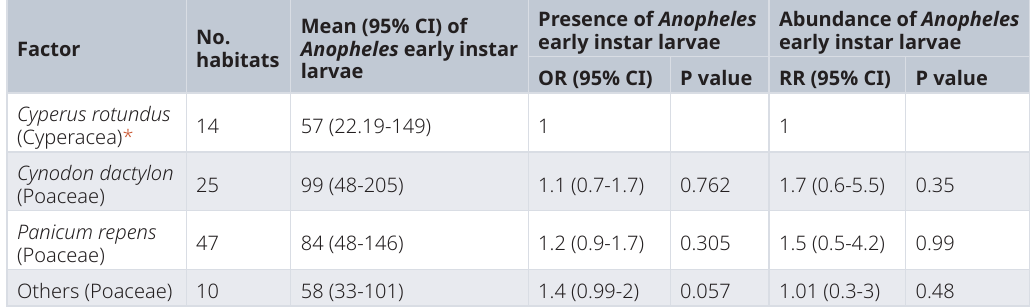
Abundance of Anopheles early instar larvae